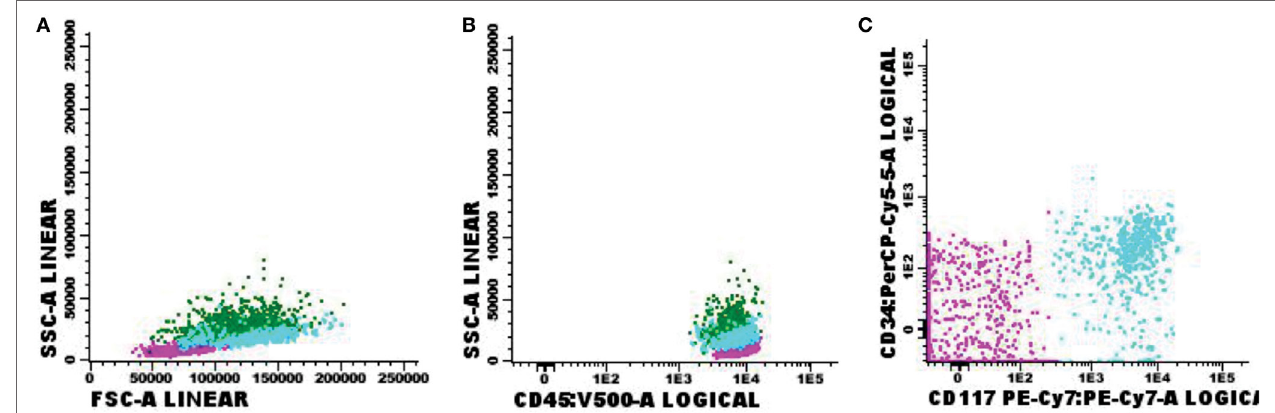
FigUre 5 | Flow cytometry results of suspected central nervous system infiltration by immature myeloid population. Presumptive diagnosis: acute myeloid leukemia. (a) Forward-scattered light (FSC size) and side-scattered light (complexity—SSC); (b) low-complexity blast population (light blue) strongly expressing CD45; (c) blast population with abnormal CD117 expression and absent CD34 expression. Sample collected in Transfix/ethylenediaminetetracetic acid with an approximate volume of 5 ml and 1 leukocyte/mm 3 and 2 red blood cells/mm 3 . Samples with 6,375 events acquired in Canto II (Becton Dickinson) and analyzed using the Infinicyt software (Cytognos). The frequency of populations in the viable cell region and CD45 + was 2,541 events.